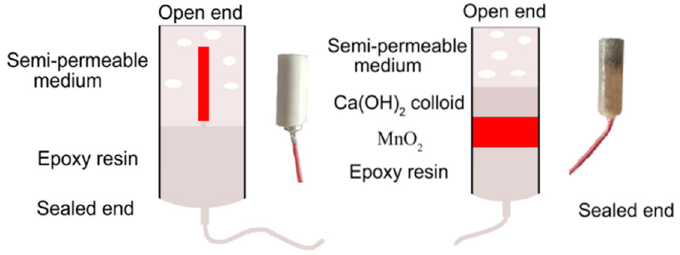
Figure 1. Package schematic diagram of Ag/AgCl and MnO 2 electrode.